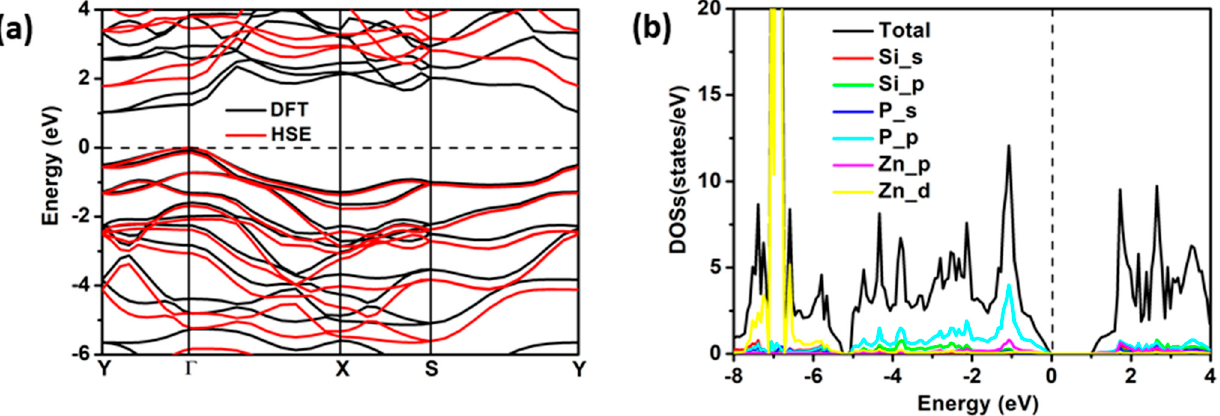
Figure 4. ( a ) The band structure (DFT-PBE and HSE functionals) and ( b ) density of states (PBE functional) for the ZnSiP 2